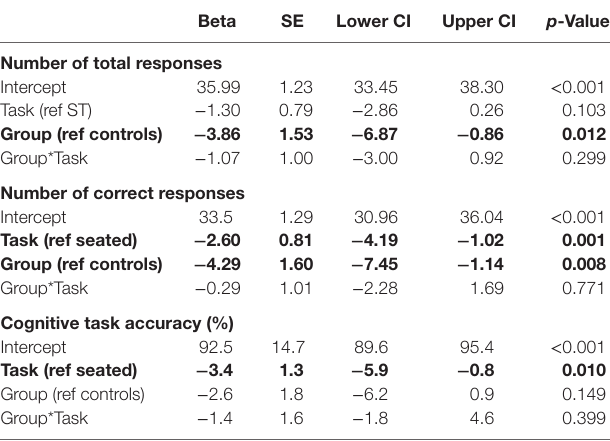
Table 5 | Results from the linear mixed models for measures of cognitive task performance.